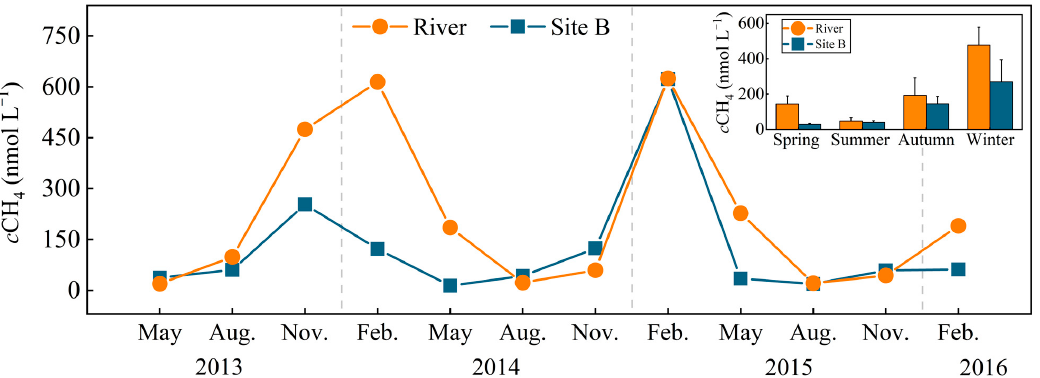
Figure 8. Temporal variation in dissolved CH 4 at the two sites (Site B and Site D) of Lake Taihu based on long-term (2013–2016) field measurement. The insert graph represents the seasonal mean dissolved CH 4 .